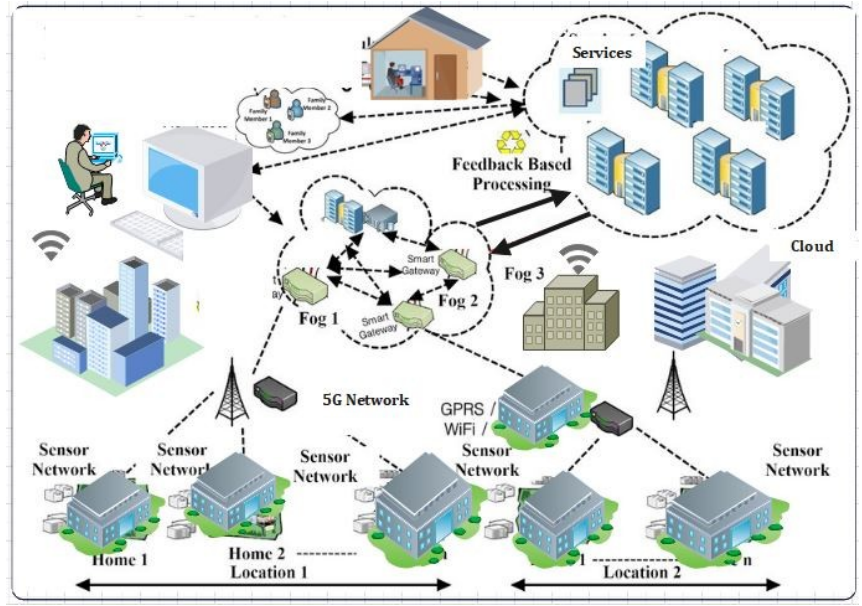
Figure 4. Proposed secure searchable encryption system using a DL-based intrusion detection system.